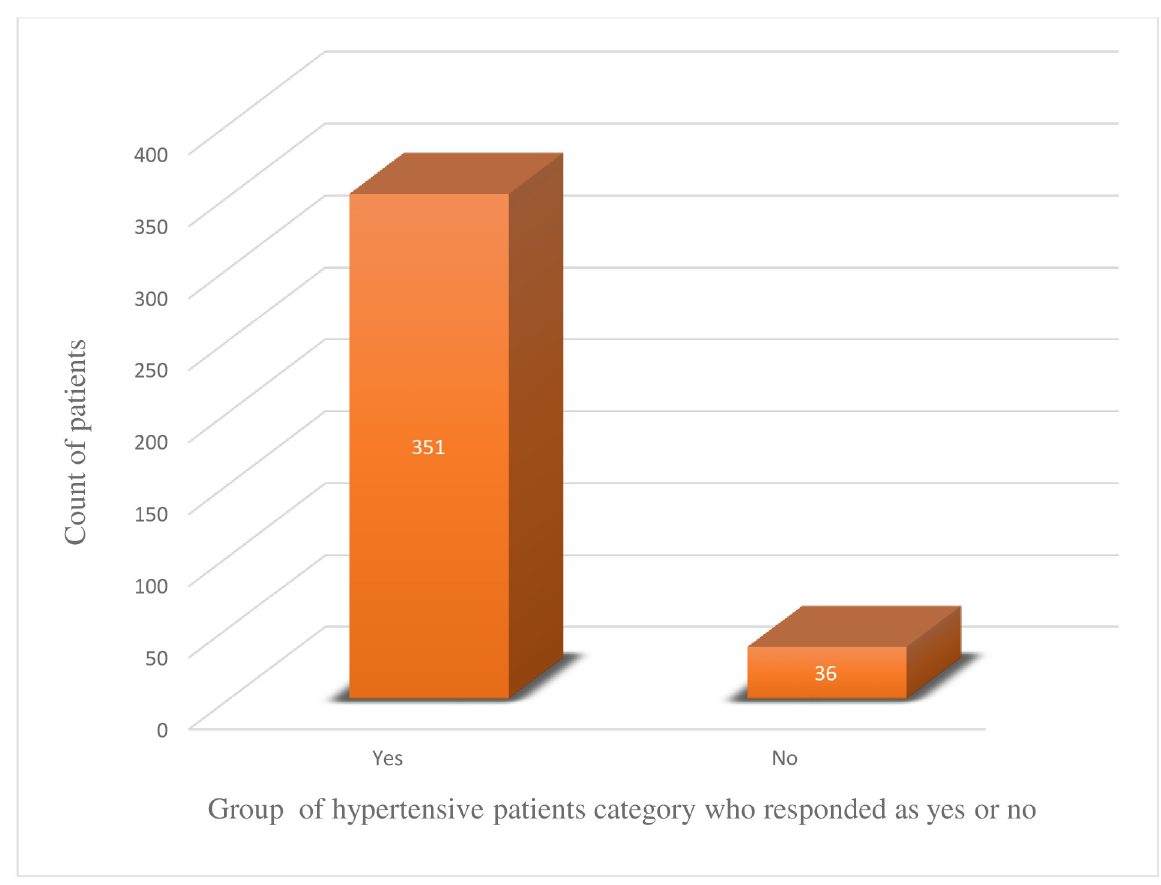
Fig 2. The number of patients who attended health education on regular exercises in health institutions.